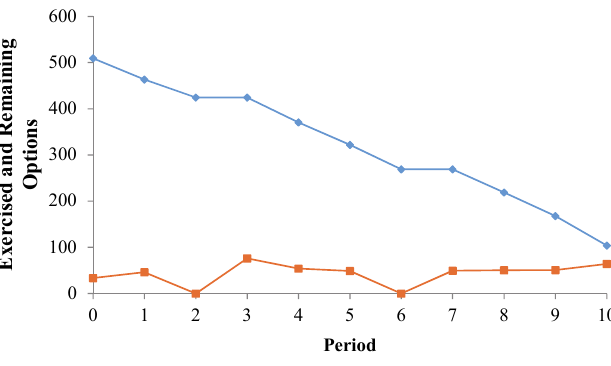
A comparison between different situations of the SC Order Quantity - 582 Retailer’s